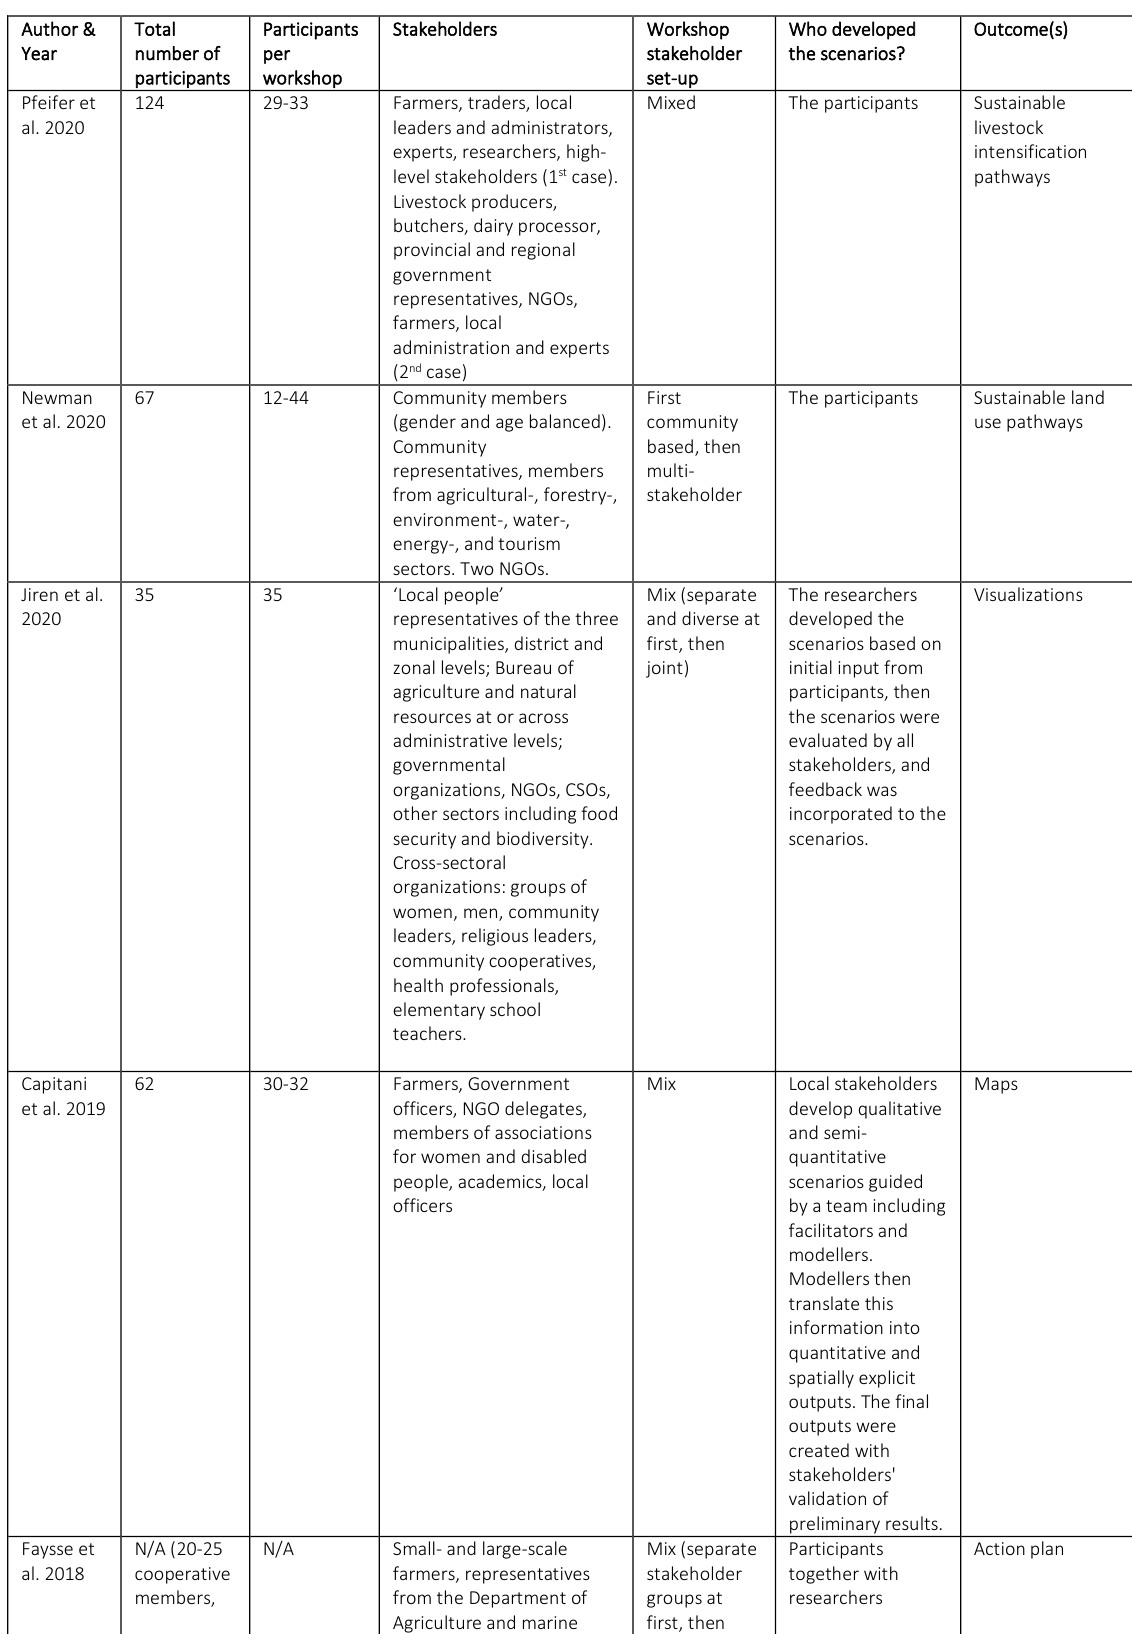
Table A1.3 Overview of the participatory scenario development set-up, in terms of number and types of participants, their role in the scenario development, and the material outcome of the research